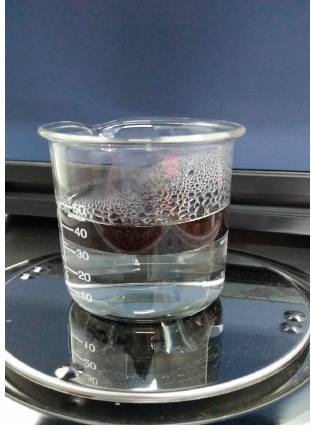
Figure 10. “Steam” phenomenon.